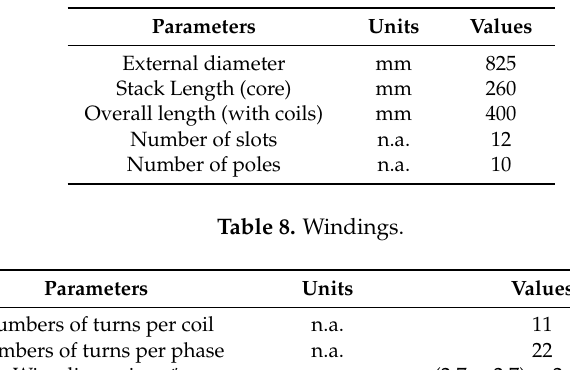
Table 7. Machine structure.